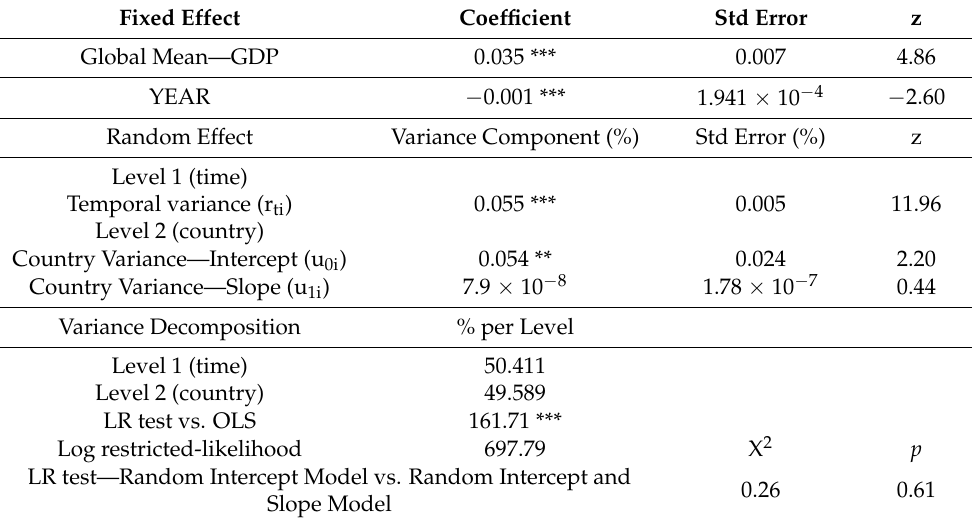
Table 8. Variance Decomposition—Linear Trend Model with Random Intercepts and Slopes